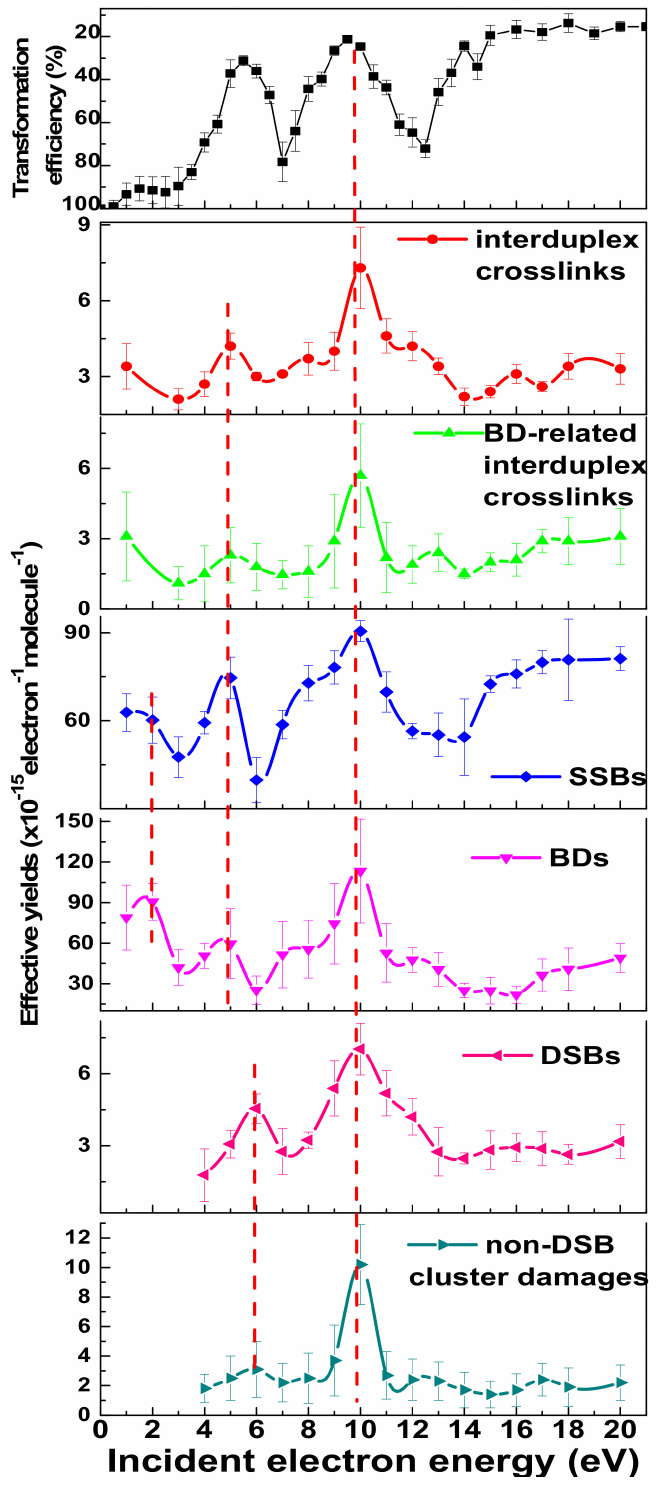
Figure 5. The upper frame is the complement of the transformation efficiency of JM109 E. Coli cells, containing PGEM3Zf(-) plasmids bombarded with LEEs of 0.5 to 21 eV [143]. It is compared to the single-electron yields of interduplex and BD-related interduplex crosslinks, SSBs, BDs, DSBs, and non-DSB clustered damage, recorded as a function of electron energy [26]. The dotted lines indicate the energies of TAs at 2, 5, 6, and 10 eV